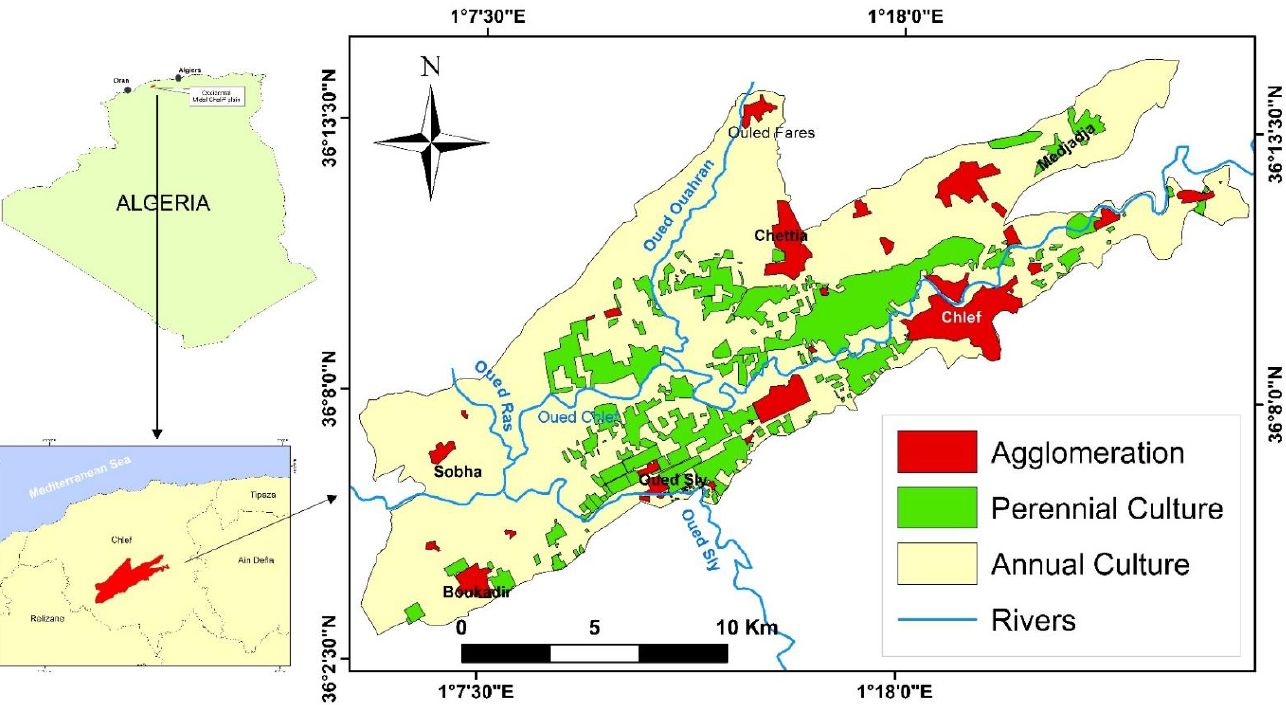
Figure 1. Localization of the study